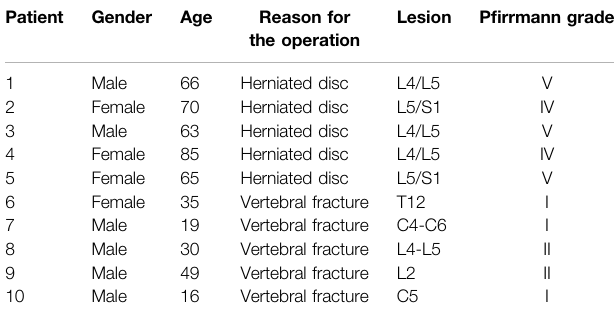
TABLE 1 | Basic information of the